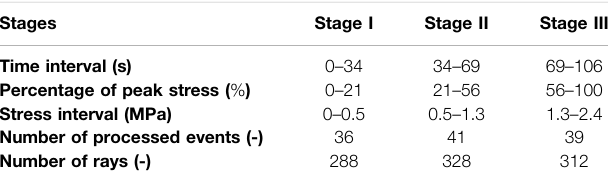
TABLE 1 | Time, stress intervals, number of events and rays at three stages of Brazilian